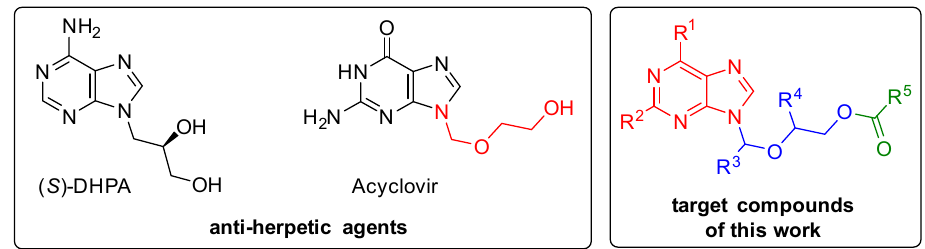
Figure 1. Examples of clinically used acyclic nucleosides and our target compounds.